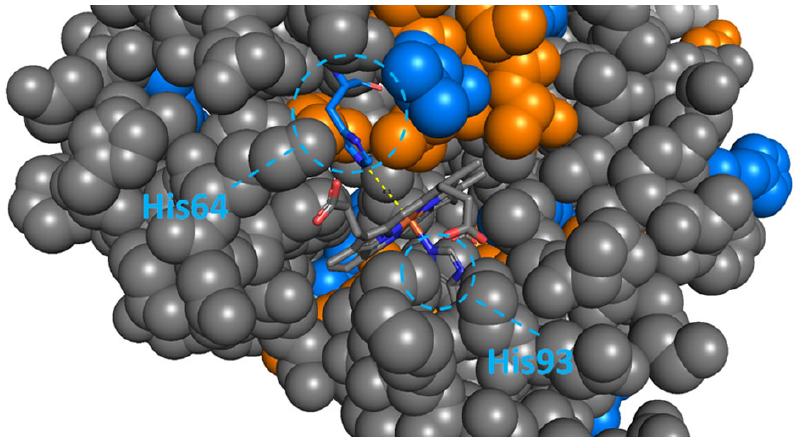
Figure 4. Crystal structure of holo -myoglobin, focussed on the binding pocket of the haem group. Highlighted residues were oxidised in the presence of ascorbic acid and hydrogen peroxide, without addition of Fe(II–EDTA. Residues in blue were identified in two independent ways with MaxQuant (either through fragmentation of two overlapping peptides, or from two different oxidative chemical modifications in the same peptide) [44,45]; those in orange were detected once (see Section 4 for details).